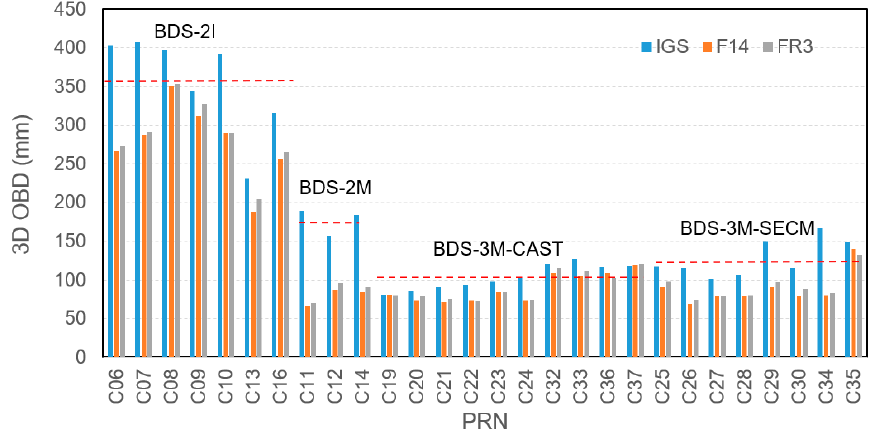
Figure 6. Influences of the three kinds of antenna models on orbit boundary disclosure for BDS satellites. The solution based on the igs14_2102.atx antenna model is represented as IGS. The BDS orbit solutions using new satellite antenna PCCs are represented as F14 as well as FR3.